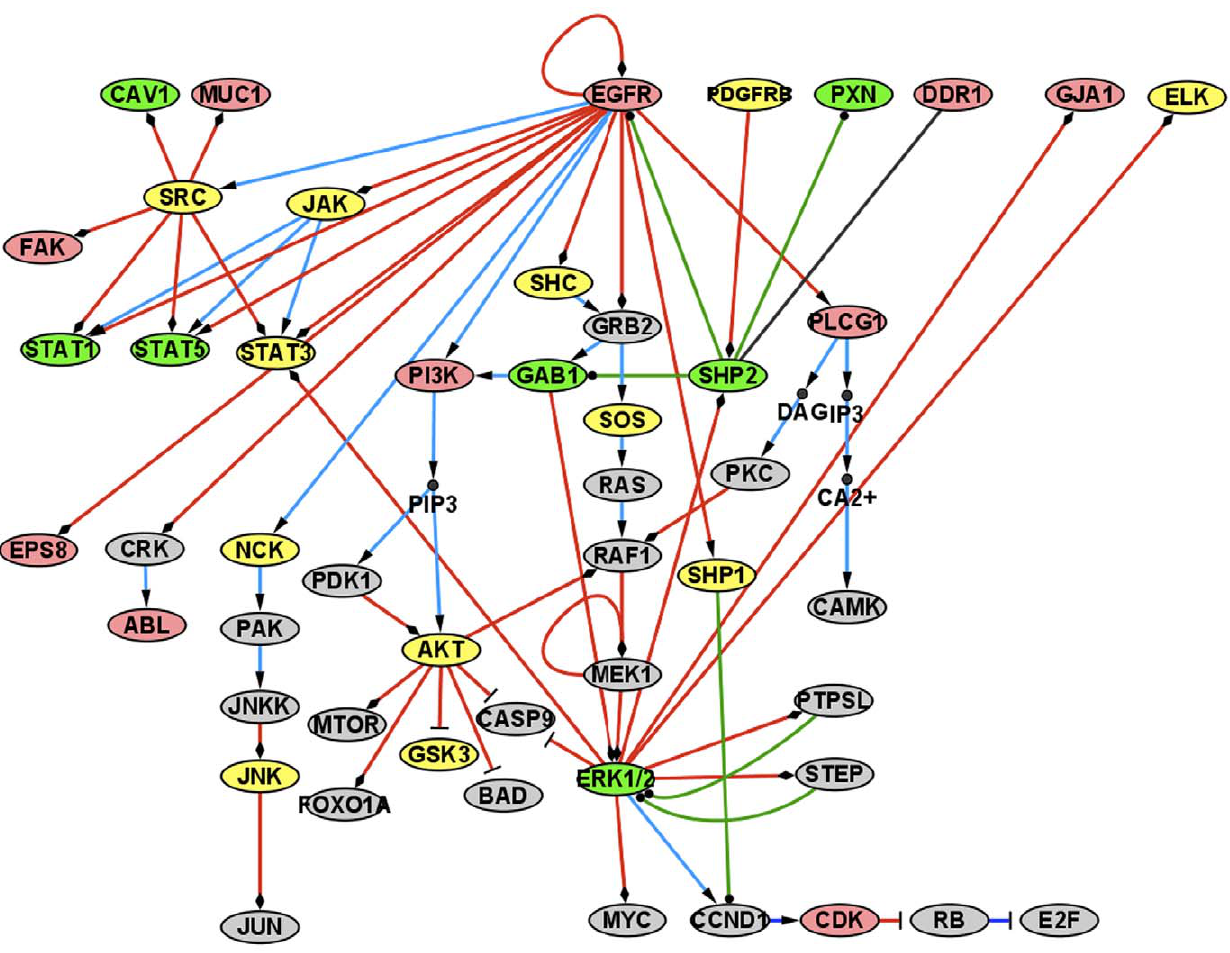
Figure 1. The EGFR signaling pathway. Pink indicates higher phosphorylation in tumor samples, while green indicates higher phosphorylation in normal tissue samples. Yellow nodes were observed to be phosphorylated, however did not change significantly in the two types. Gray nodes were not observed in the analysis. A red arrow (or edge) relates a kinase to its target, green edges indicate a phosphatase and its target. Blue edges indicate activation, which may not be direct. Finally, a diamond shape on the end of an edge indicates phosphorylation, while a circle indicates an inhibition of phosphorylation. Arrowheads indicate activation, which may be indirect.